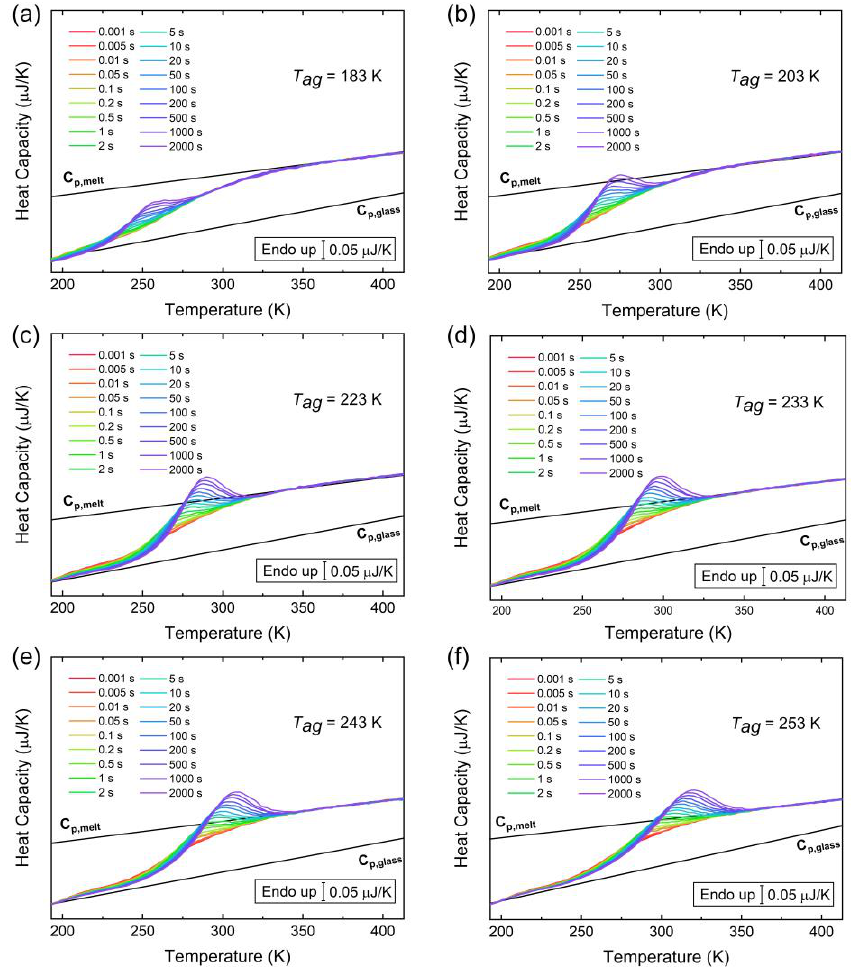
Figure 2. Heat capacity curves at the indicated aging times and the following aging temperatures: ( a ) 183 K; ( b ) 203 K; ( c ) 223 K; ( d ) 233 K; ( e ) 243 K; and ( f ) 253 K.